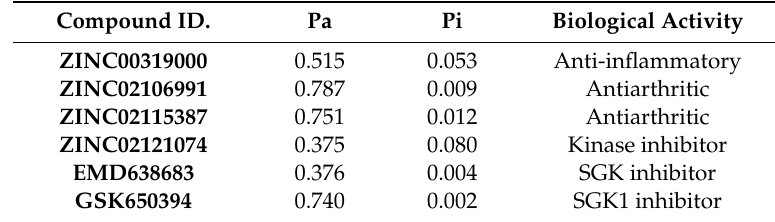
Table 4. Biological activity prediction of the selected compounds along with the known SGK1 inhibitors.